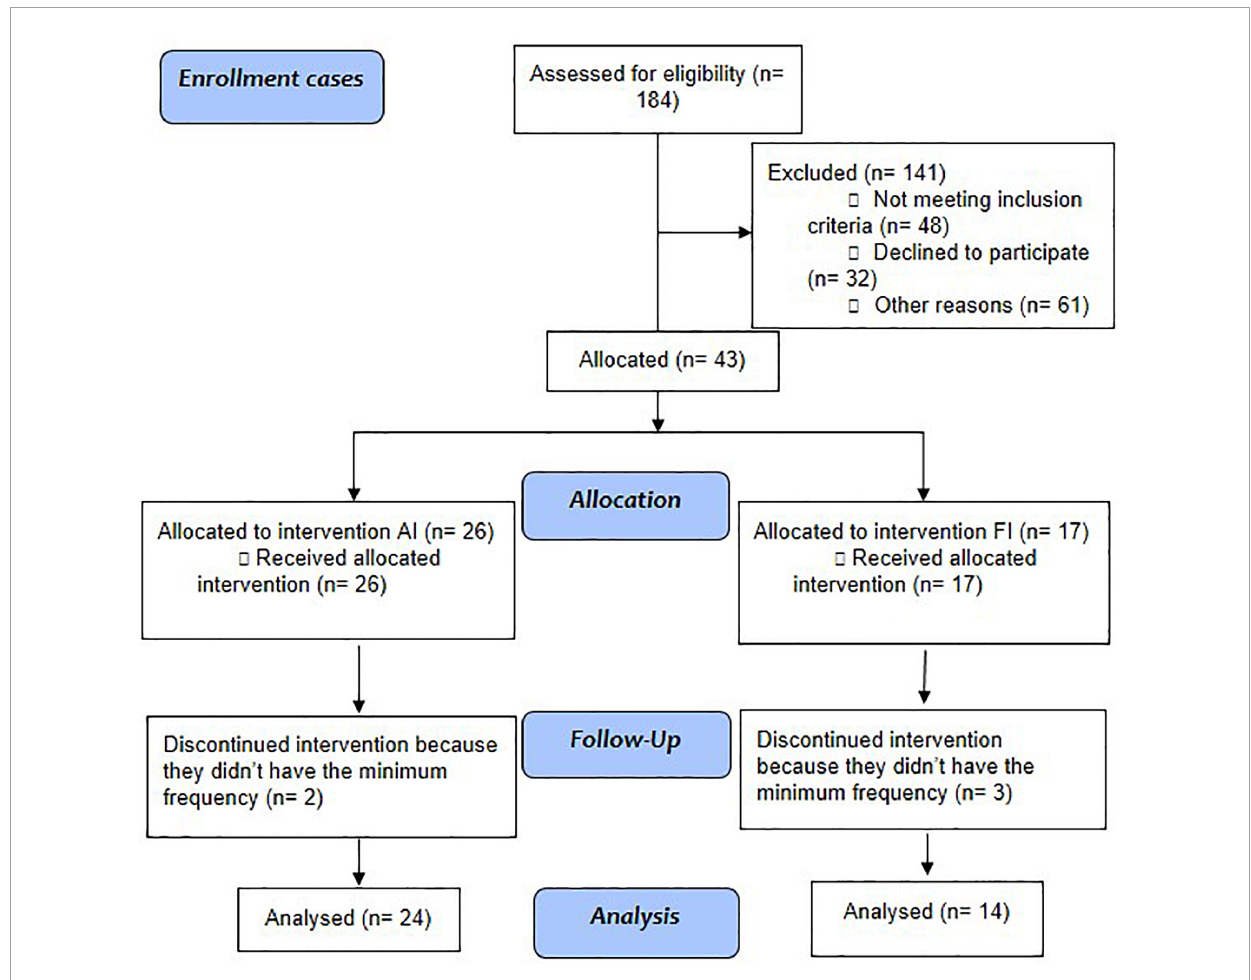
FIGURE1 Study flowchart: Aerobic intervention (AI) and functional intervention (FI) in patients with schizophrenia.